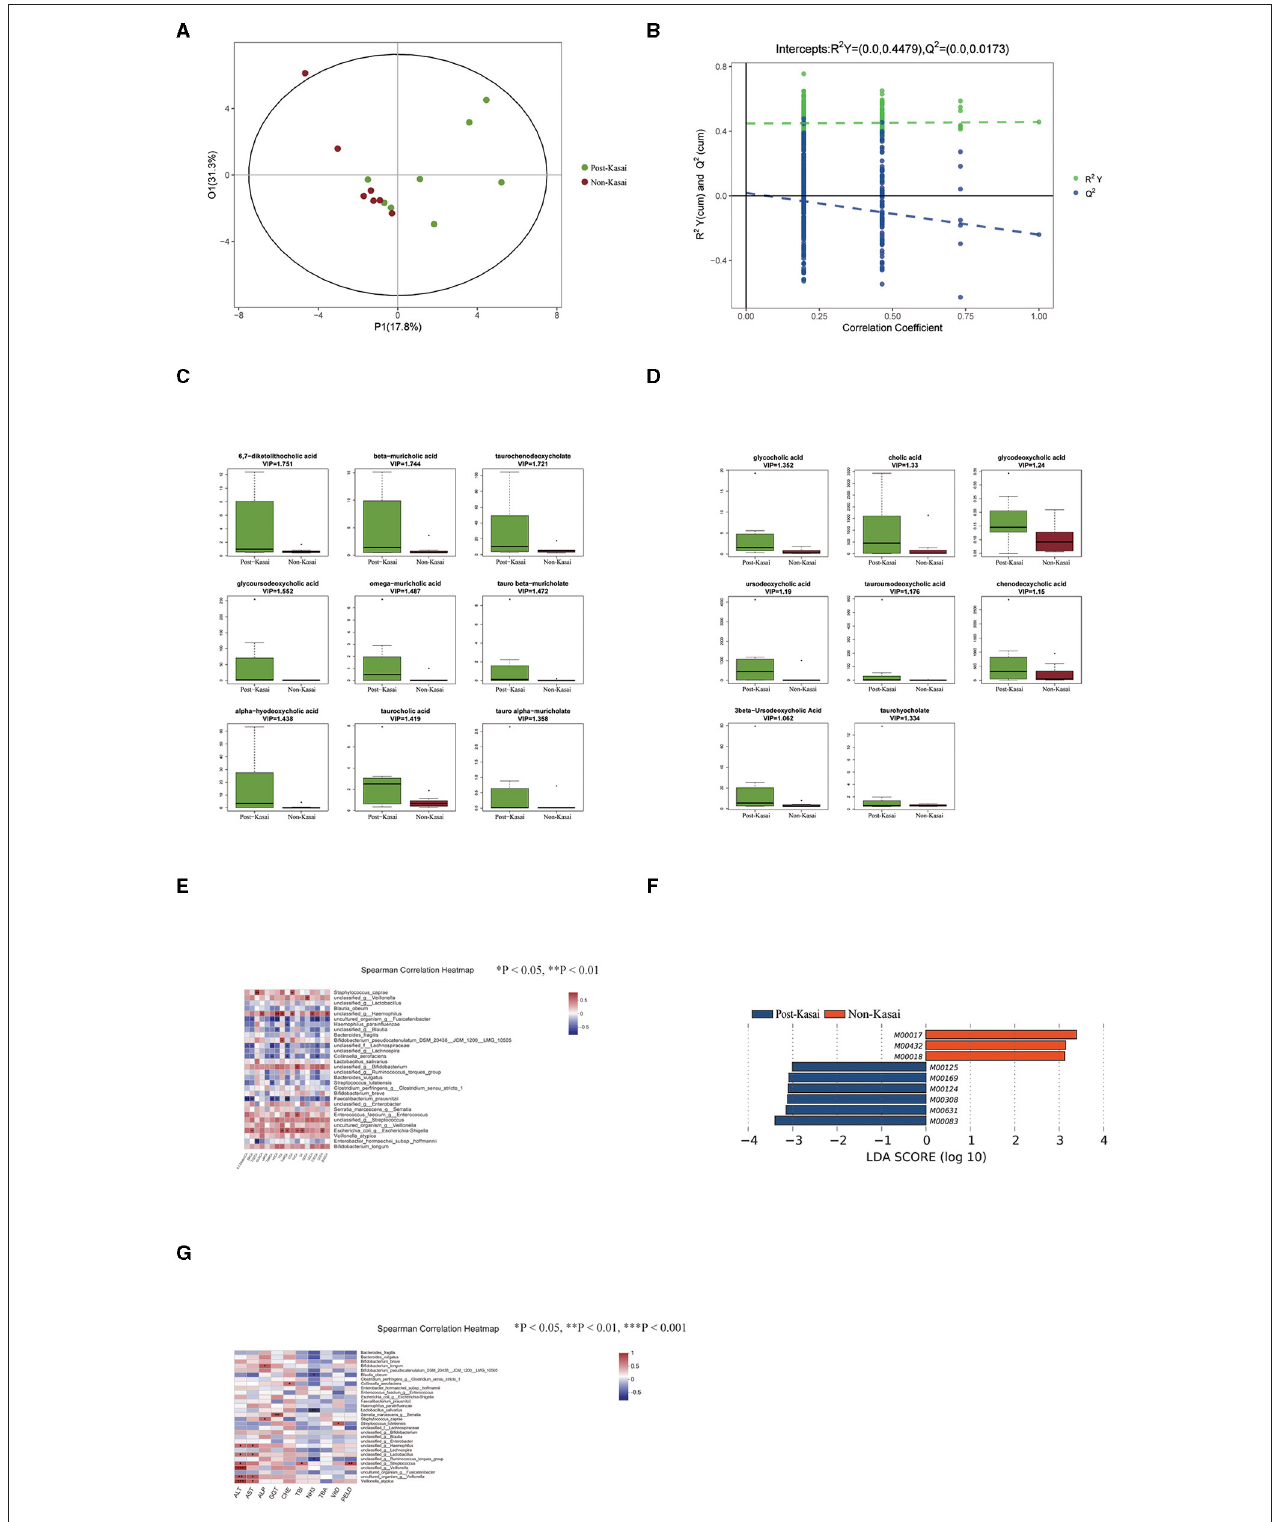
FIGURE 2 | (A,B) Significant differences in stool bile acid composition between the post-Kasai and non-Kasai groups identified by OPLS-DA (left: OPLS-DA map; right: model verification map OPLS-DA). Model verification map of OPLS-DA: the x axis represents the replacement retention of the replacement test; the y axis represents the R2 (green dot) and Q2 (blue dot) replacement test values. The two dashes represent the regression lines of R2 and Q2, respectively. (C,D) Differential